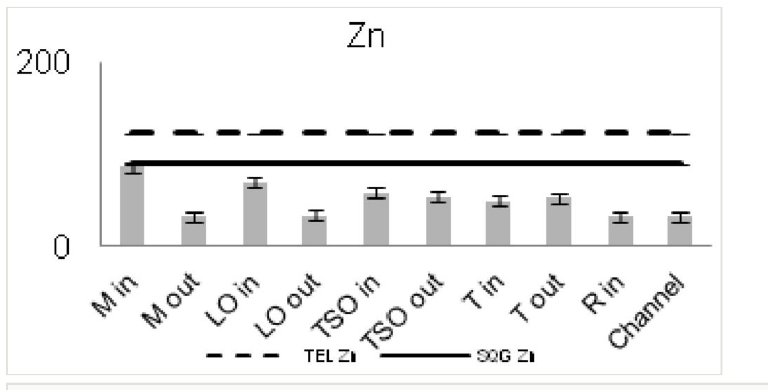
Figure 9. Zn concentrations in the sediment from each station. The dashed line represents the TEL threshold. The continuous line represents the SQG threshold. Abbreviations of the stations as in Fig. 8.